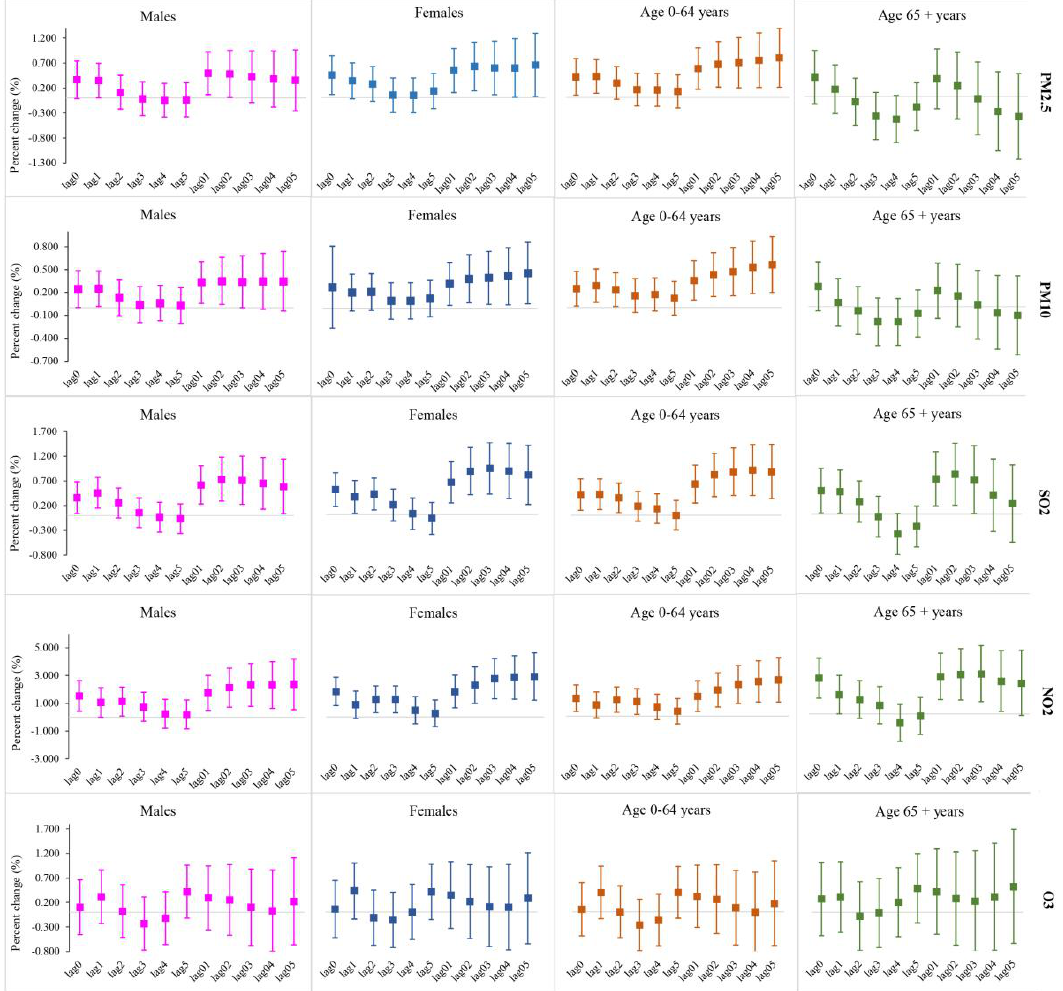
Figure 3. The percent change and 95% CI for hospitalization due to respiratory disease associated with a 10- μ g/m 3 increases in air pollutants concentrations by gender and age in single-pollutant models in Taiyuan,